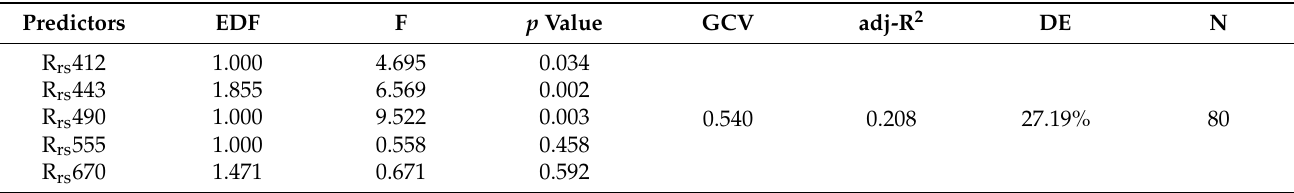
Table 10. Statistical summary of the fitted chlorophyceae GAM.